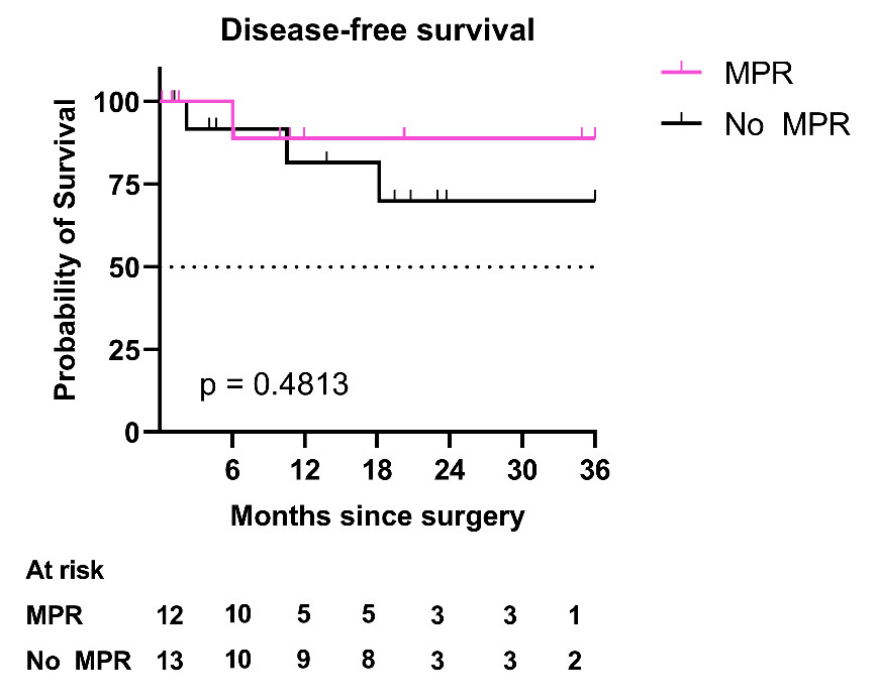
Figure 6. Three-year disease-free survival in the ICI group. Kaplan–Meier curves of 3-year disease-free survival in patients of the ICI group with MPR versus patients without MPR. Abbreviations: ICI: immune checkpoint inhibitors; MPR: major pathological response.